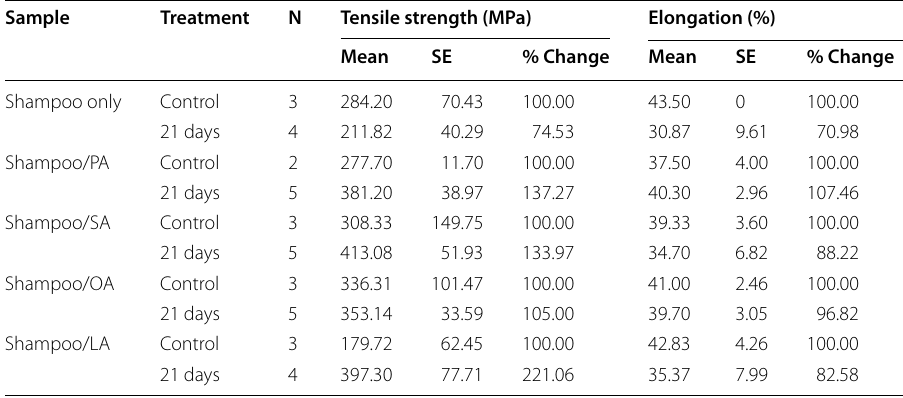
Table 14 Tensile strength and elongation of bleached hair after shampoo with or without the use of hair conditioner containing four types of fatty acids